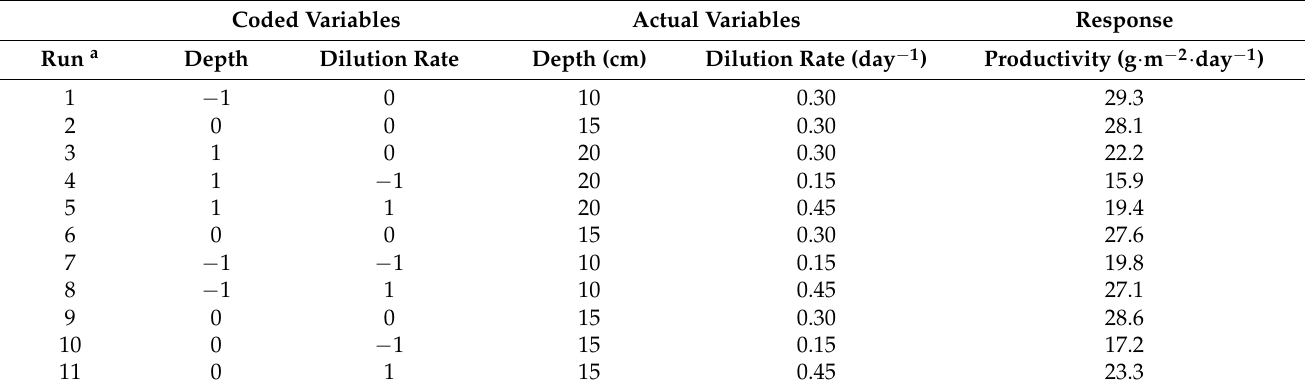
Table 1. Central composite response surface design for biomass productivity. Actual Variables